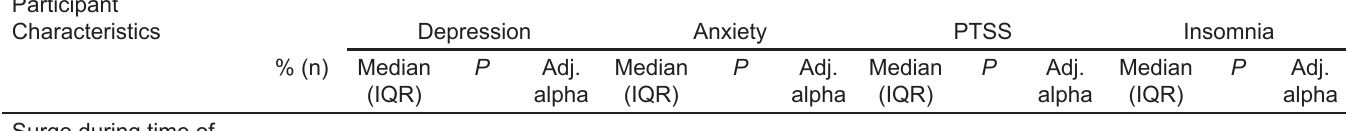
Table 4. Relationship between pandemic-related factors and psychological